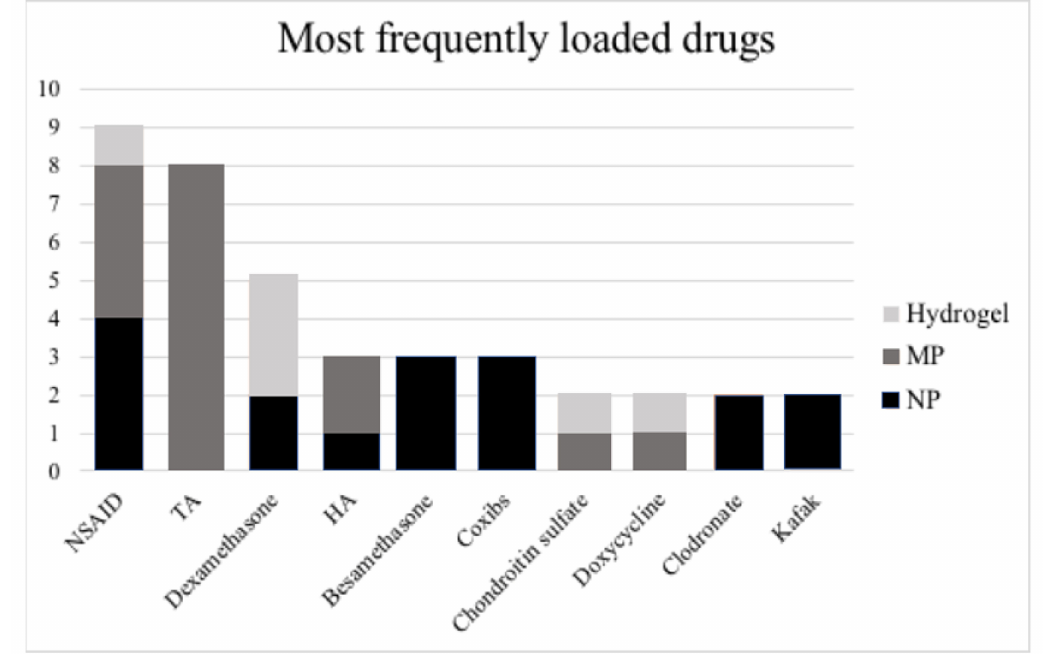
Figure 4. Distribution of drugs loaded on the different types of delivery systems in the included studies. Legend: HA— Hyaluronic acid, NSAID—non-steroidal anti-inflammatory drug; TA—Triamcinolone